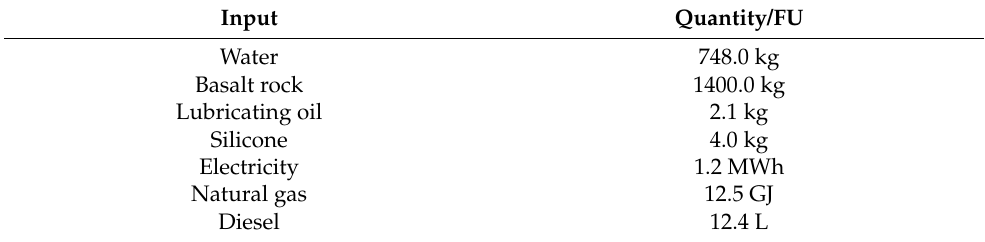
Table 4. Material and energy inputs associated with basalt fiber production per functional